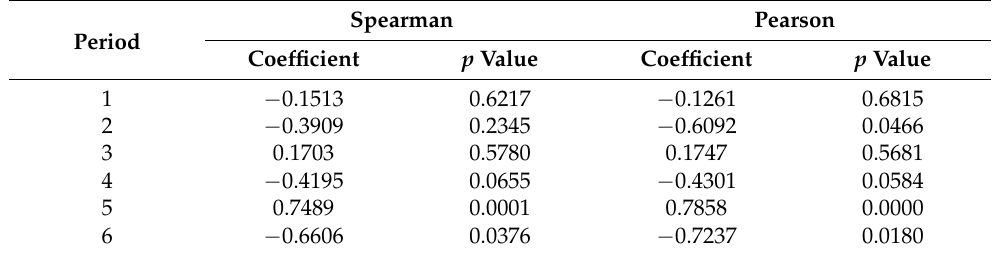
Table 4. Correlations between weekly number of diagnostic delays and infection degrees.